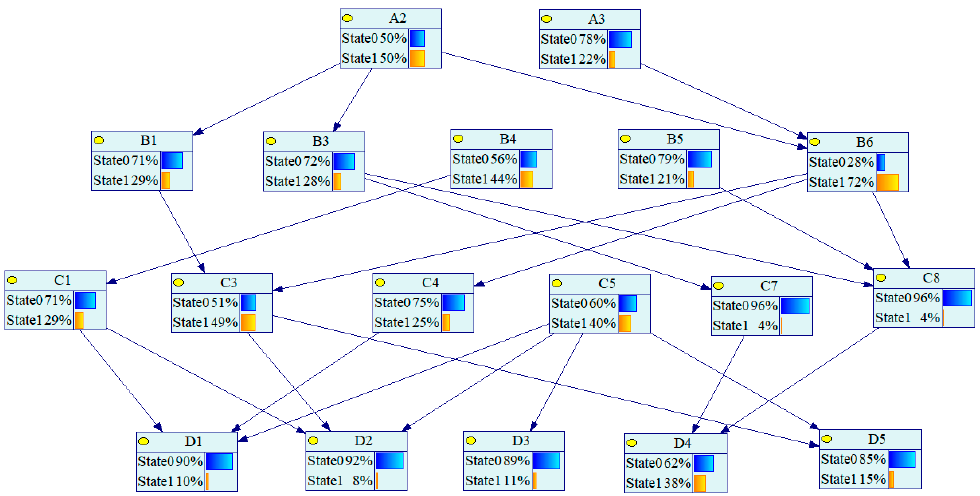
Figure 5. BN model of unsafe acts in gas explosion accidents based on GeNIe.